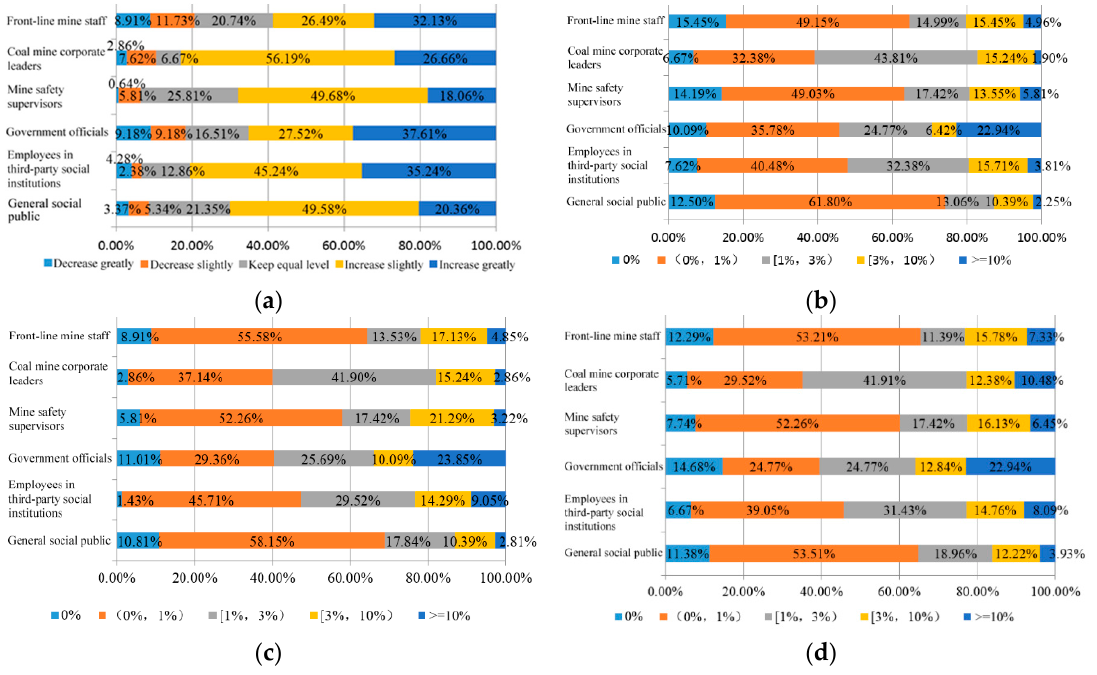
Figure 3. Occupation safety and health WTP of subjects with different identity. ( a ) Occupation safety and health tax WTP; ( b ) Occupation safety and health item WTP; ( c ) Occupation safety and health subject WTP; ( d ) Occupation safety and health event WTP.